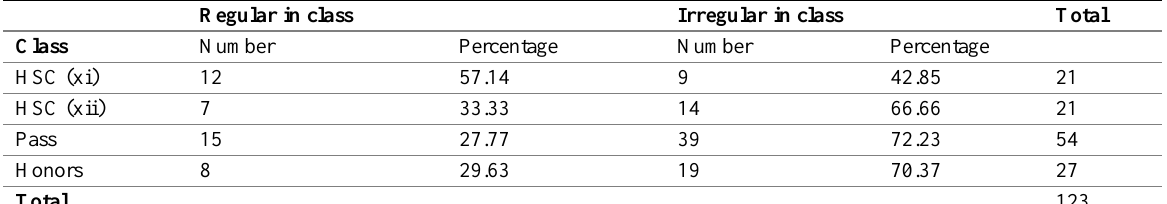
Table 1: Attendance in College-A (3% of total students)